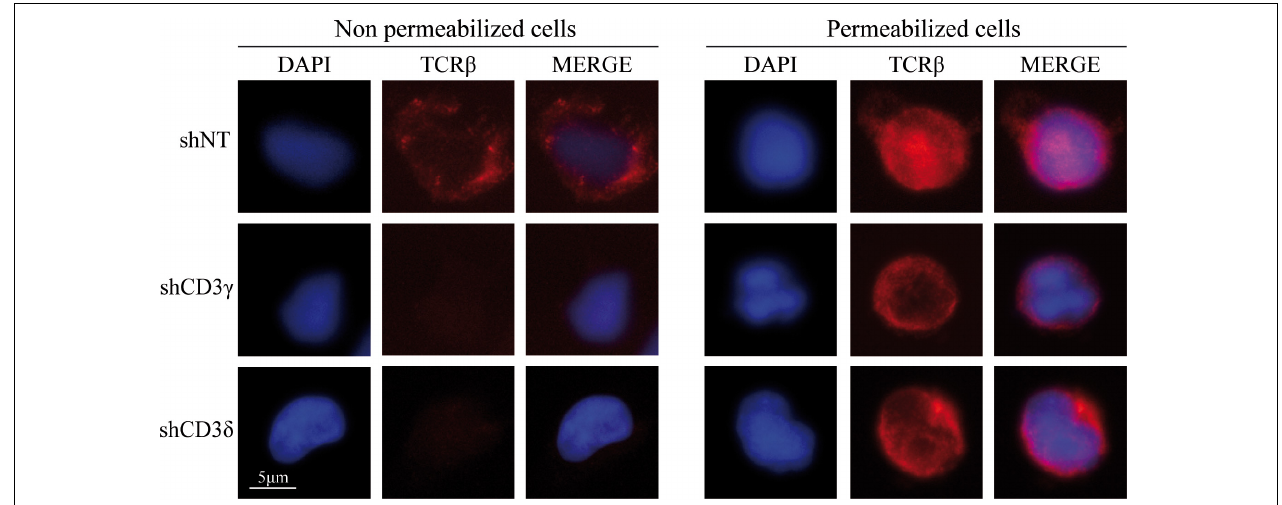
FIGURE 8 | Extracellular (left) and intracellular (right) TCR β expression in CD3G or CD3D KD T-cell lines. Jurkat E6-1 shNT, shCD3 γ , and shCD3 δ cells were left untreated (unpermeabilized) or were treated with Triton X-100 (permeabilized) and incubated with anti-TCR β antibody (JOVI-1) and anti-mouse AF594 secondary antibody before analysis by fluorescence microscopy. Nuclei were stained with